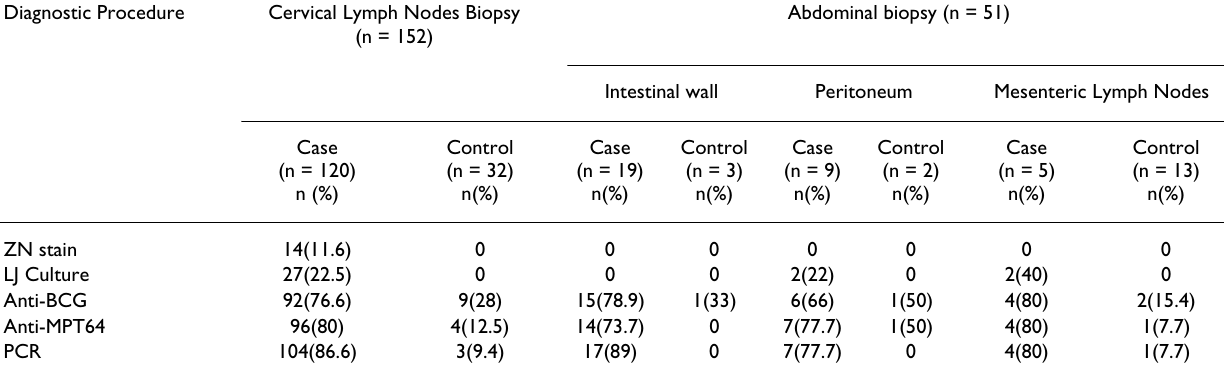
Table 2: Positive results of different diagnostic procedure on cervical lymph nodes and abdominal biopsies. Diagnostic